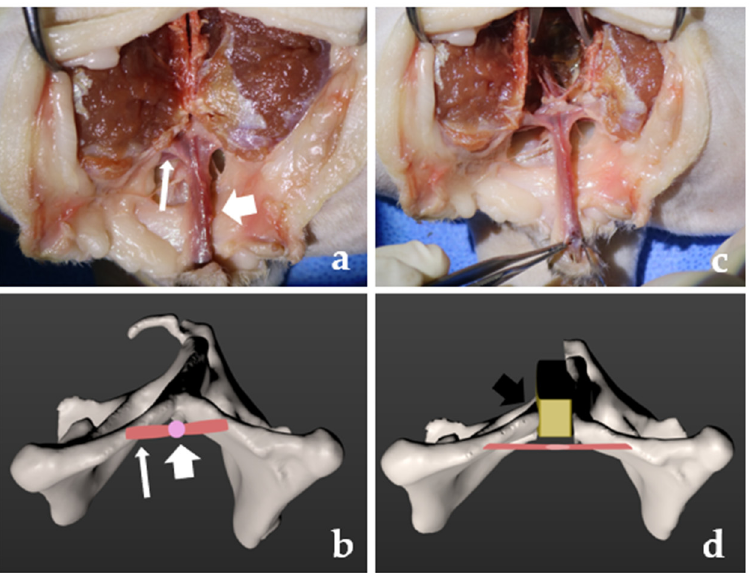
Figure 3. Postoperative retrograde urethrogram under the guide of C-arm fluoroscopy. Insertion of the urine catheter was impeded, and the narrow urethra was confirmed on the ischium level ( a ). Marked improvement of the contrast flow into the bladder was noted after ischiocavernosus muscle release ( b ).